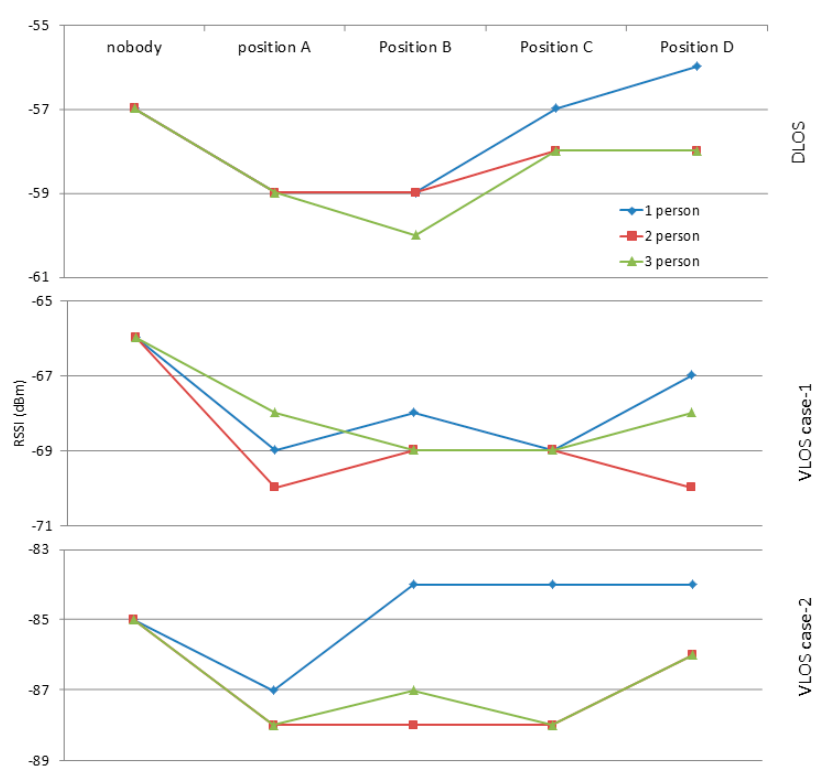
Figure 22. PPE in VLOS case 2.